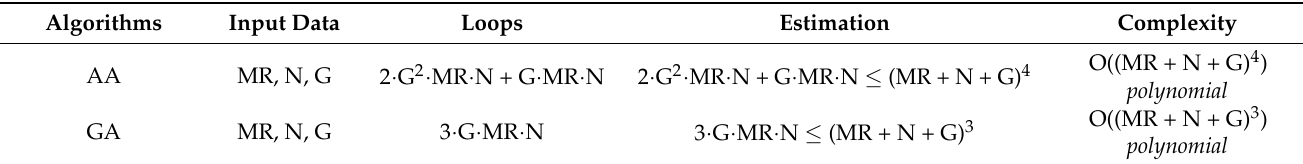
Table 3. The computational complexity of the